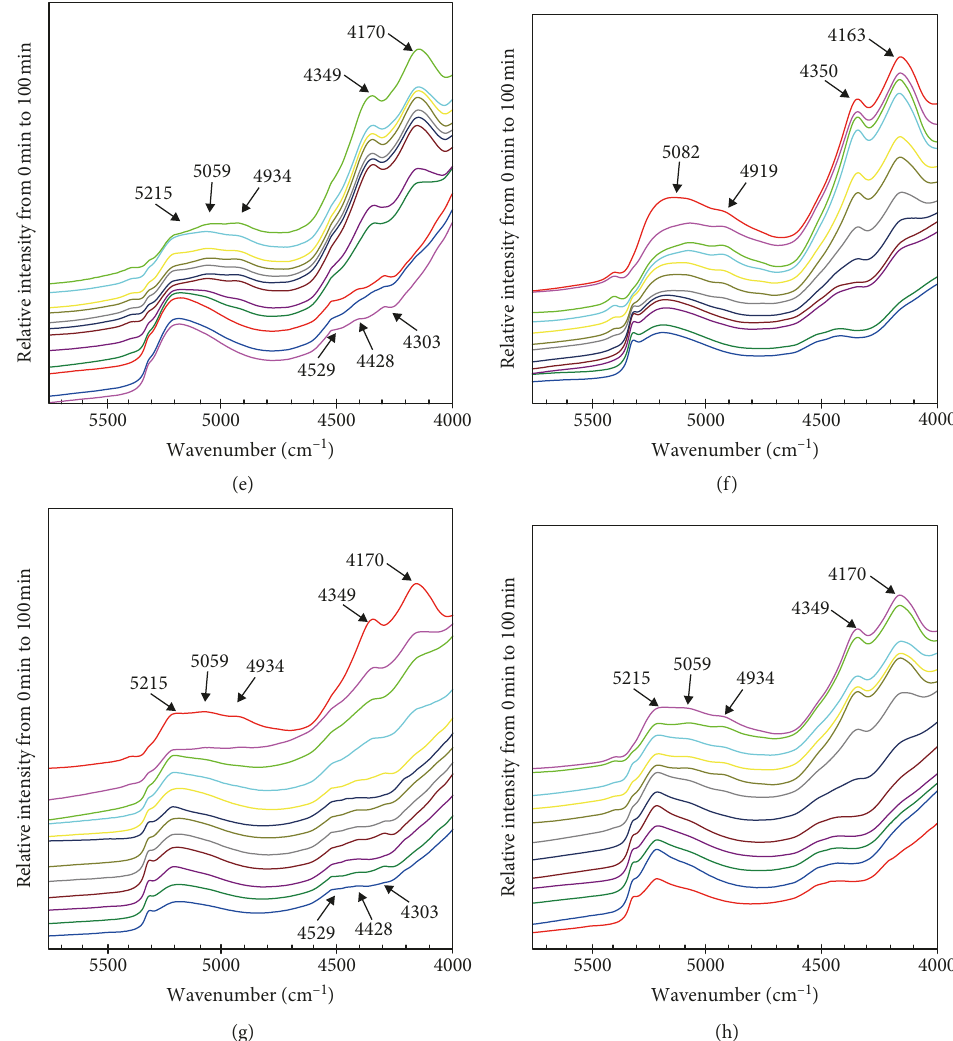
1 region. (a) S1 (hydrozincite and −